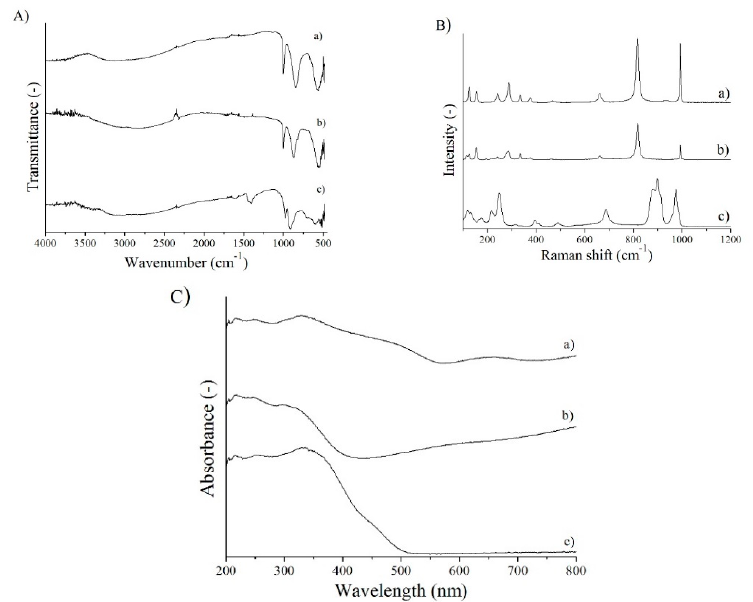
Figure 5. FT-IR ( A ), Raman ( B ), and UV–Vis ( C ) spectra of different MoO 3 phases, (a) MoO 3 -10, monoclinic phase (CrCl 3 , 240 °C, 6 h), (b) MoO 3 -8, orthorhombic phase (CTAB, 240 °C, 6 h), (c) MoO 3 -1, hexagonal phase (90 °C, 3 h) .